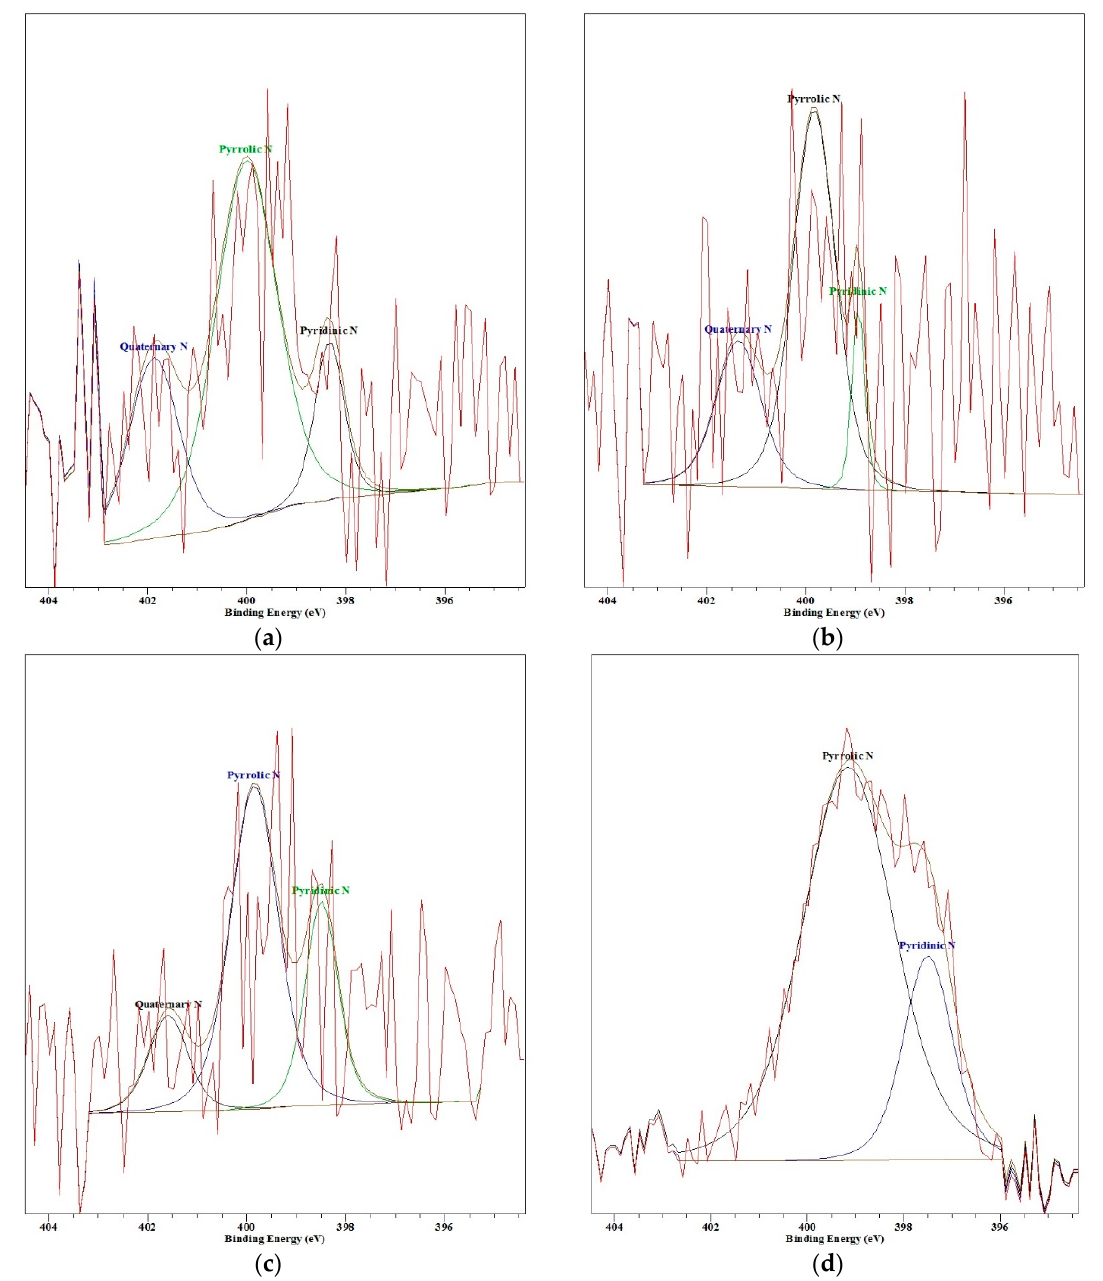
Figure 8. Nitrogen 1s XPS spectra ( a ) 200 °C; ( b ) 250 °C; ( c ) 300 °C; ( d ) 400 °C.